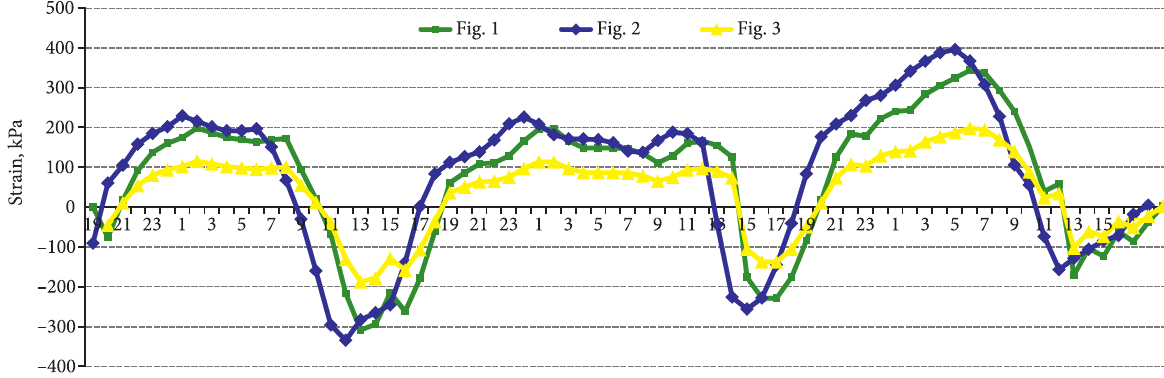
Fig. 1: load a Fig. 1: load b Fig. 1: load c Fig. 2: load a Fig. 2: load b Fig. 2: load c Fig. 3: load a Fig. 3: load b Fig. 3: load c